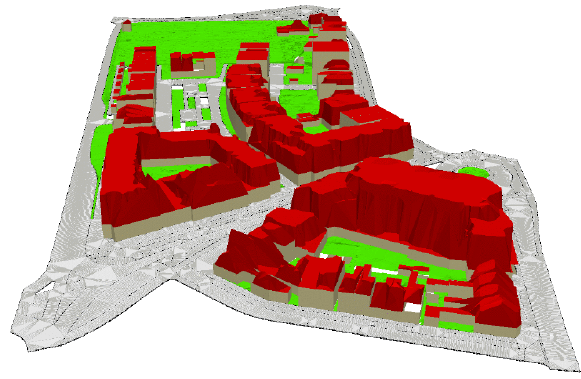
Figure 1: Automatic 3d